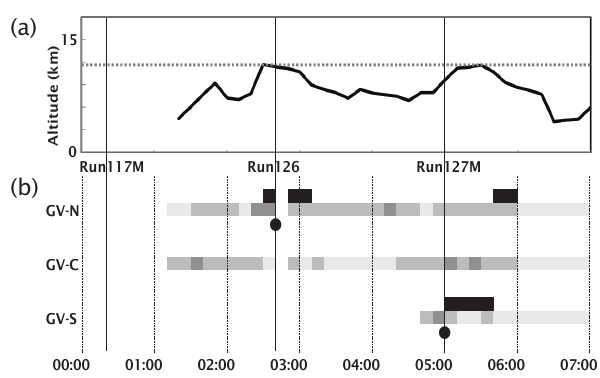
Figure 4. Time series analysis of localised convective activity from radar data. The data set spans 22 November, 00:00 to 07:00 only. (a) Echotop time series, from Newcastle radar data, for Grose Val- ley fire. The horizontal dotted line indicates the tropopause alti- tude determined from the Williamtown radiosonde measurement on 22 November at 00:00 (12kma.s.l.; Fromm et al., 2012). (b) Radar summaries. Black bars indicate pyro-tops over 9kma.s.l. Grey bars represent 10min typical reflectivity, with the grey shade indicating reflectivity class values. Vertical black lines indicate key overhead remote-sensing passes. The black dots indicate identified fire chan- nelling events.